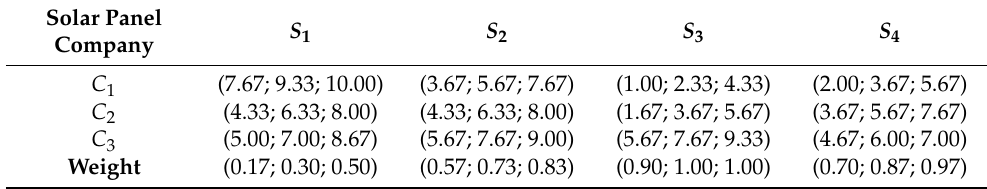
Table 9. Fuzzy decision matrix for M 1